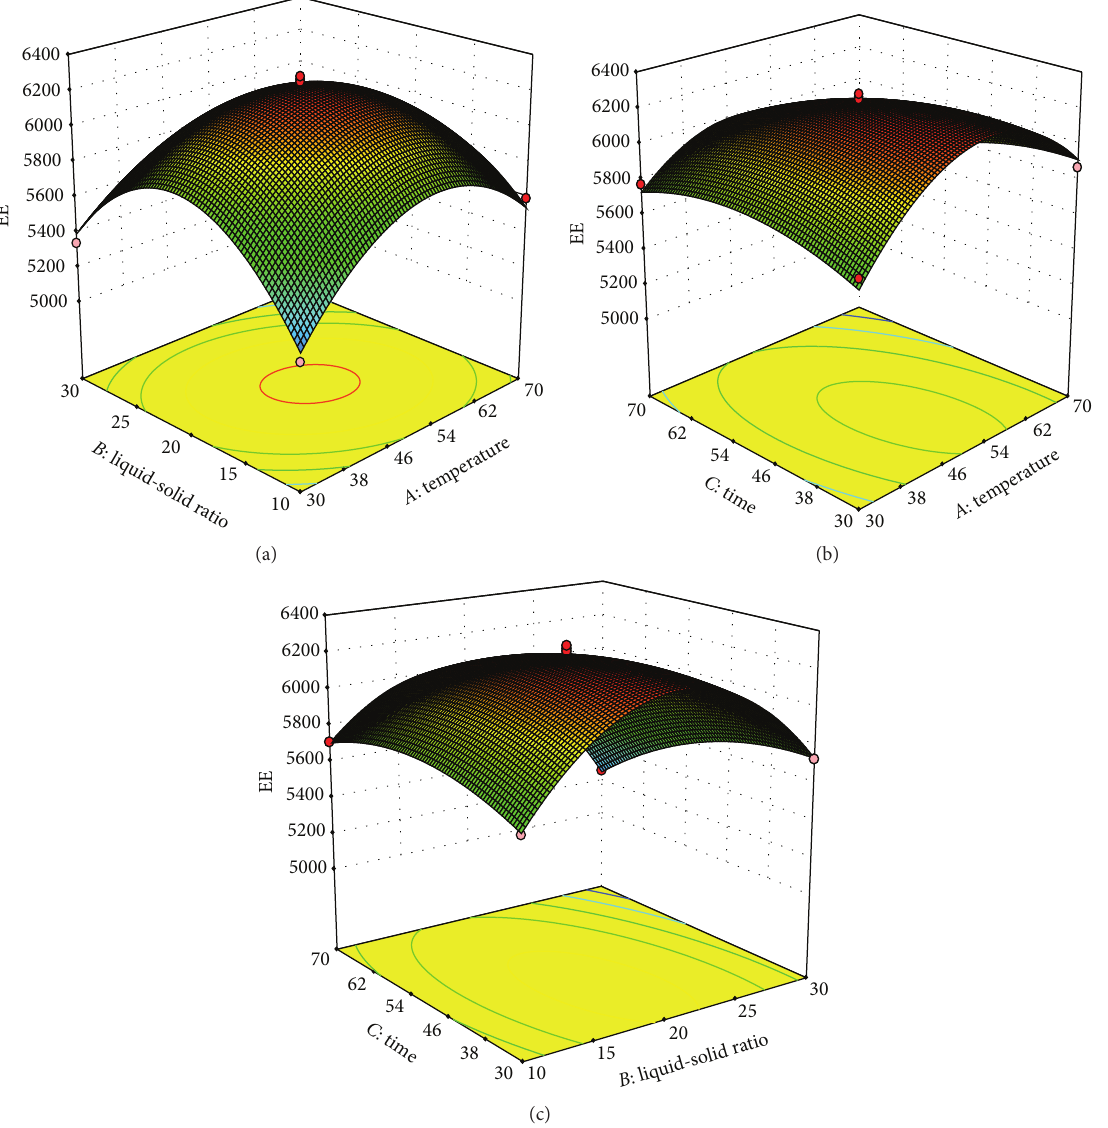
Figure 2: 3D response surface presenting the effect of influence factors on the EE of gallic acid. Interaction between temperature and liquid- solid ratio (a). Interaction between temperature and time (b). Interaction between liquid-solid ratio and time